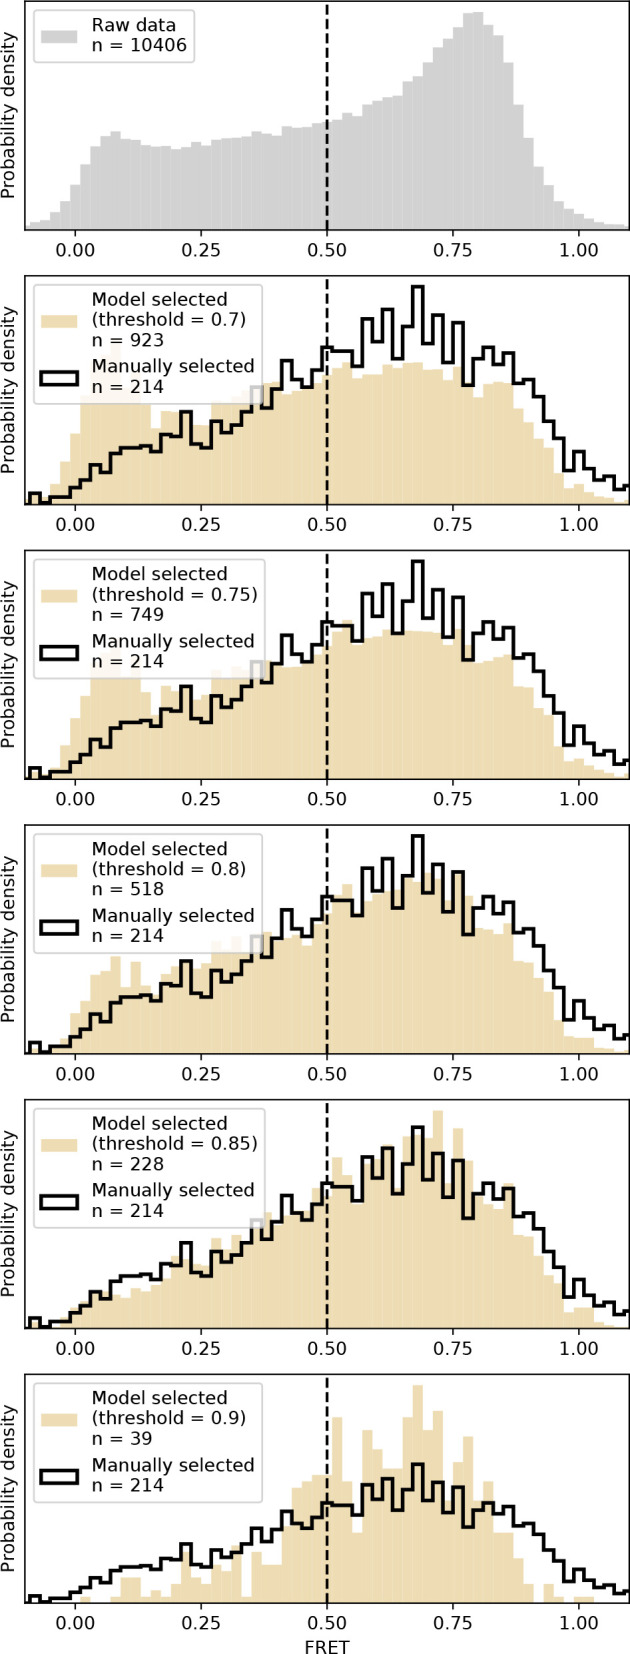
DeepFRET applied to experimentally-obtained data.We applied DeepFRET to a previously obtained smFRET dataset on CRISPR-Cas12a. At the DeepFRET threshold of ~0.8–0.85 an excellent agreement with previously used sorting methodologies involving manual inspection of data was achieved.